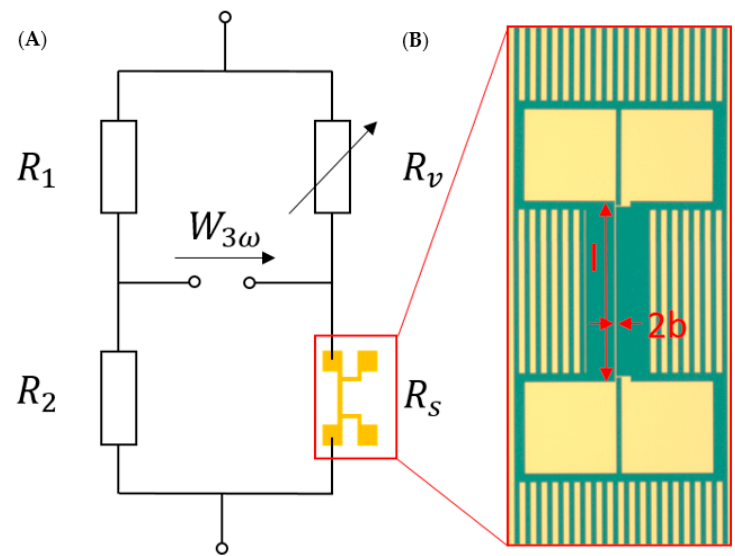
Figure 1. ( A ) Wheatstone bridge layout. R 1 and R 2 are high-precision resistances chosen in such a way that most of the current passes through the heater, R v is a variable decade resistance, and R s is the sample resistance. ( B ) 3 ω metal heater deposited on top of a SiO 2 thin film with length l , width 2b, and two contact pads on each side. Heaters in this work had theoretical lengths from 9 to 15 mm and widths from 2 to 6 µm. The image is not depicted to scale.